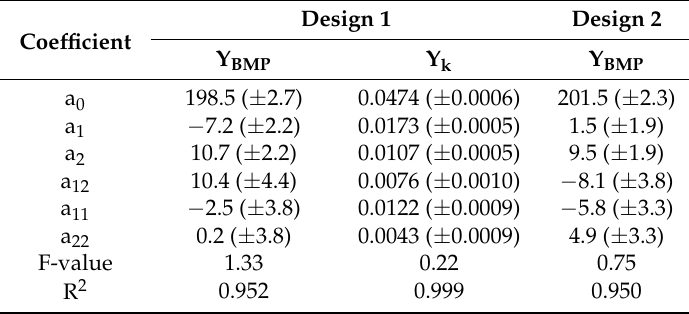
Table 2. Coefficients, Fisher value, and R 2 of the two designs.